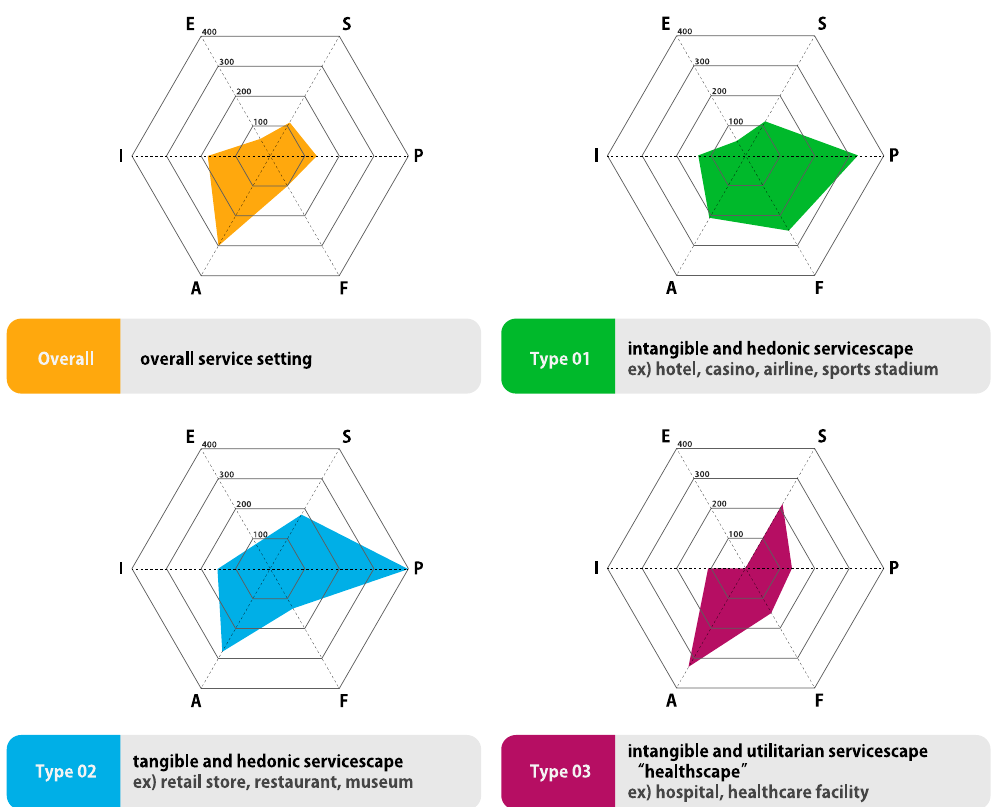
Figure 3. Results of factor classification by servicescape typology. Note : The abbreviations of the indicators are described as follows. (E): External variables, (I): Interior variables, (A): Ambient variables, (F): Functional variables, (P): Product/Furniture/Displays variables, (S): Social variables.